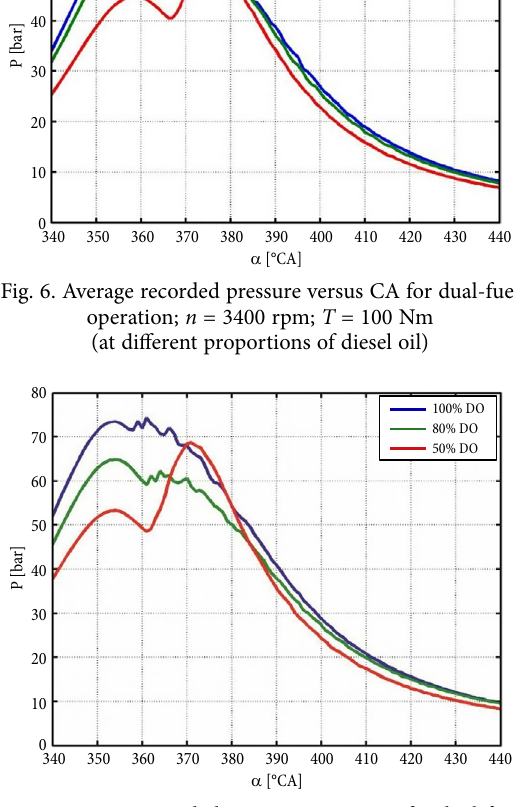
Fig. 7. Average recorded pressure versus CA for dual-fuel operation; n = 3400 rpm; T = 150 Nm (at different proportions of diesel oil)